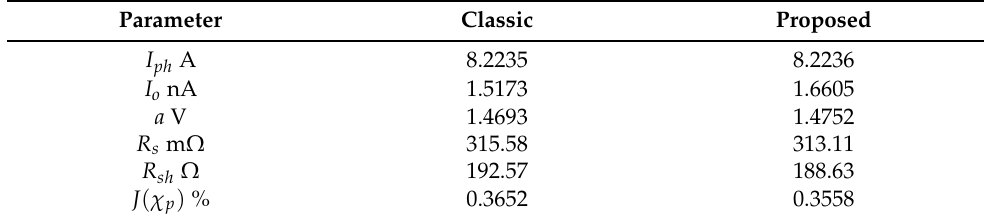
Table 2. Results for the different tests conducted in the experiment.